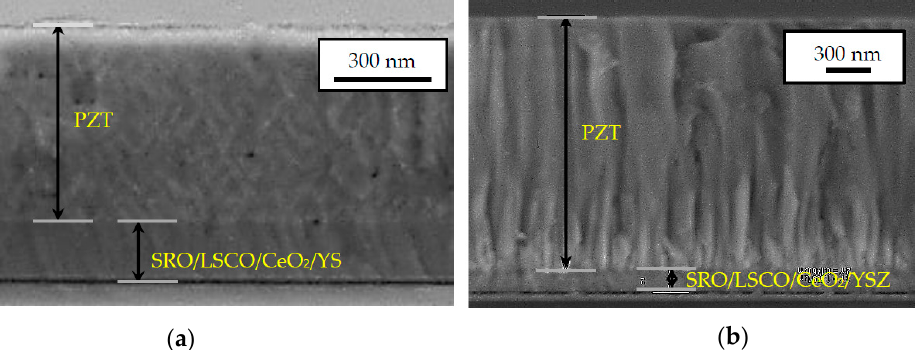
Figure 3. Typical SEM cross-section images of ( a ) monocrystalline and ( b ) fibered-epitaxial thin films.